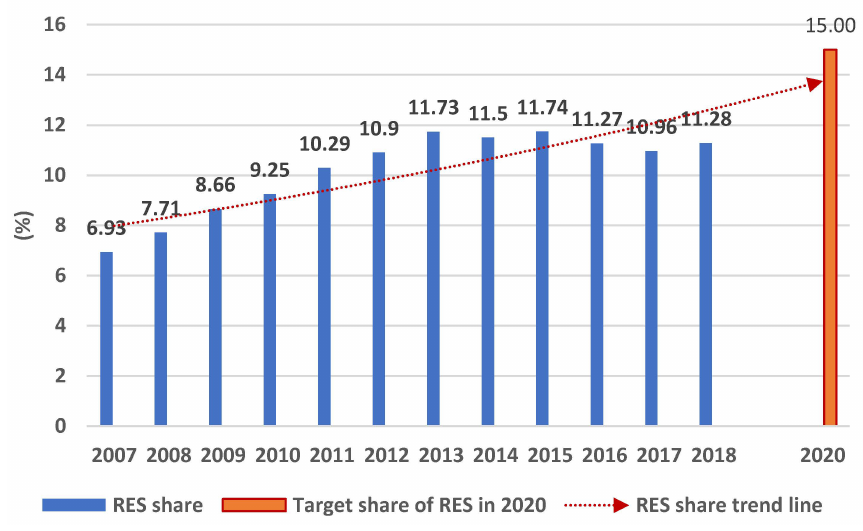
Figure 4. The share of energy from renewable sources in gross final energy consumption in 2018. Own study, based on